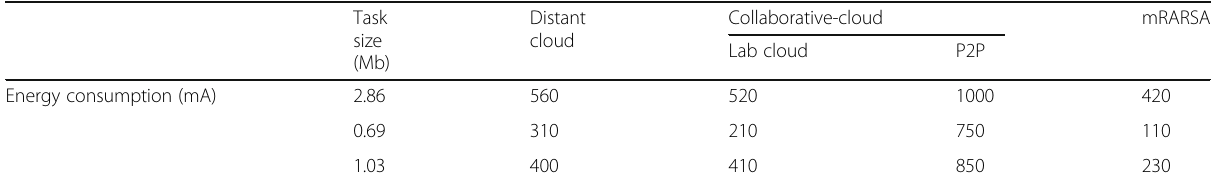
Table 9 Energy consumption performance evaluation